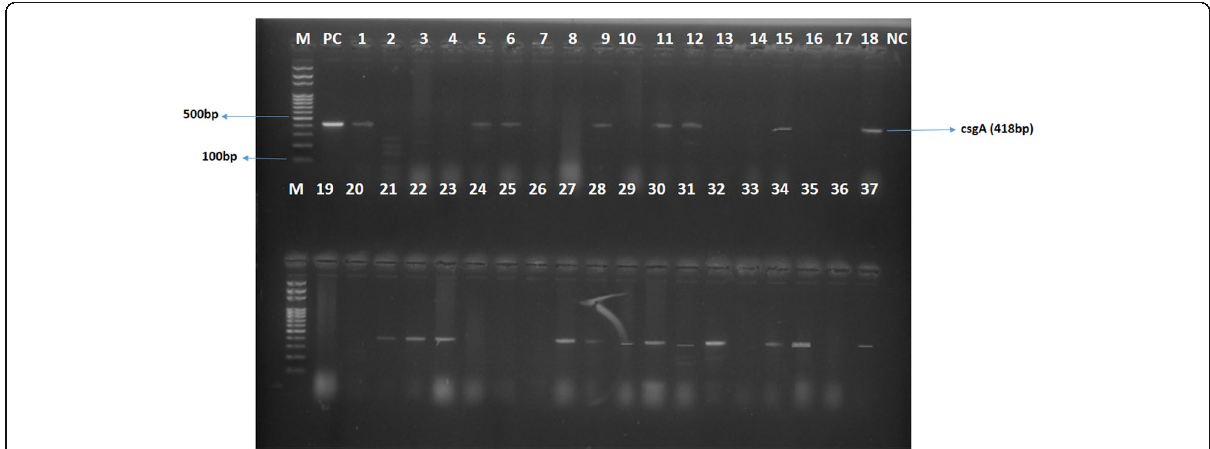
Fig. 4 Agarose gel image of PCR products showing bands for csgA (418 bp). Lane M: Molecular maker, Lane 1, 5, 6, 9, 11, 12, 15, 18, 21, 22, 23, 27, 28, 29, 30, 31, 32, 34, 35 and 37 are positive for